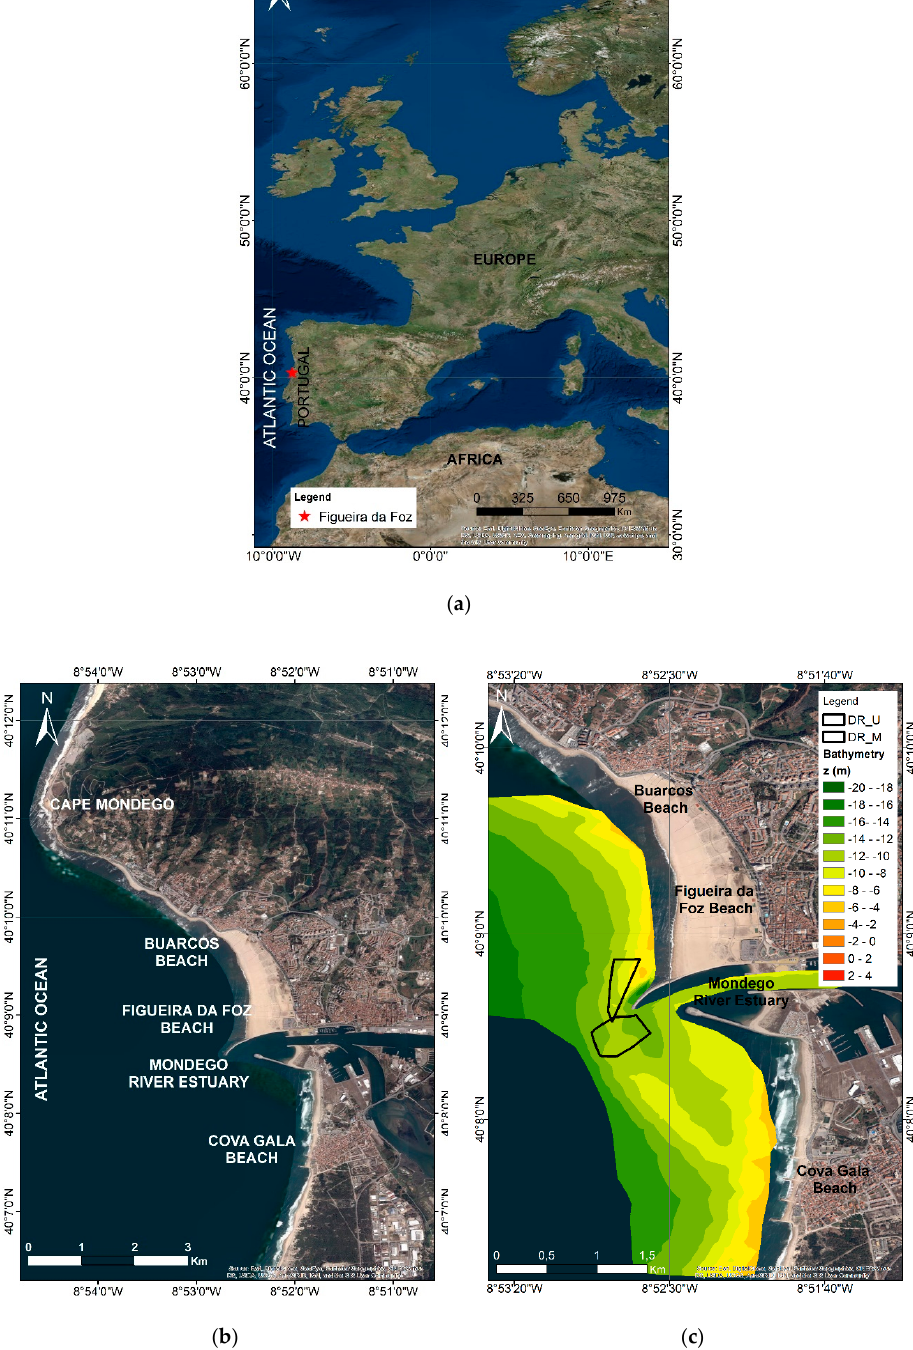
Figure 1. Study area map: ( a ) Europe—Figueira Foz, ( b ) Figueira Foz coastal system, ( c ) bathymetry of 2015 at Figueira da Foz tidal inlet. The polygons show the areas where dredging operations are normally